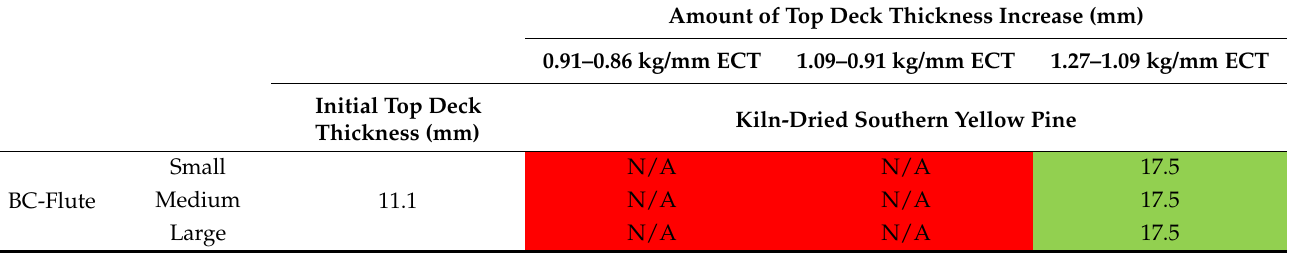
Table 7. The amount of top deck board thickness required to optimize unit loads consisting of KD SYP pallet and BC-flute